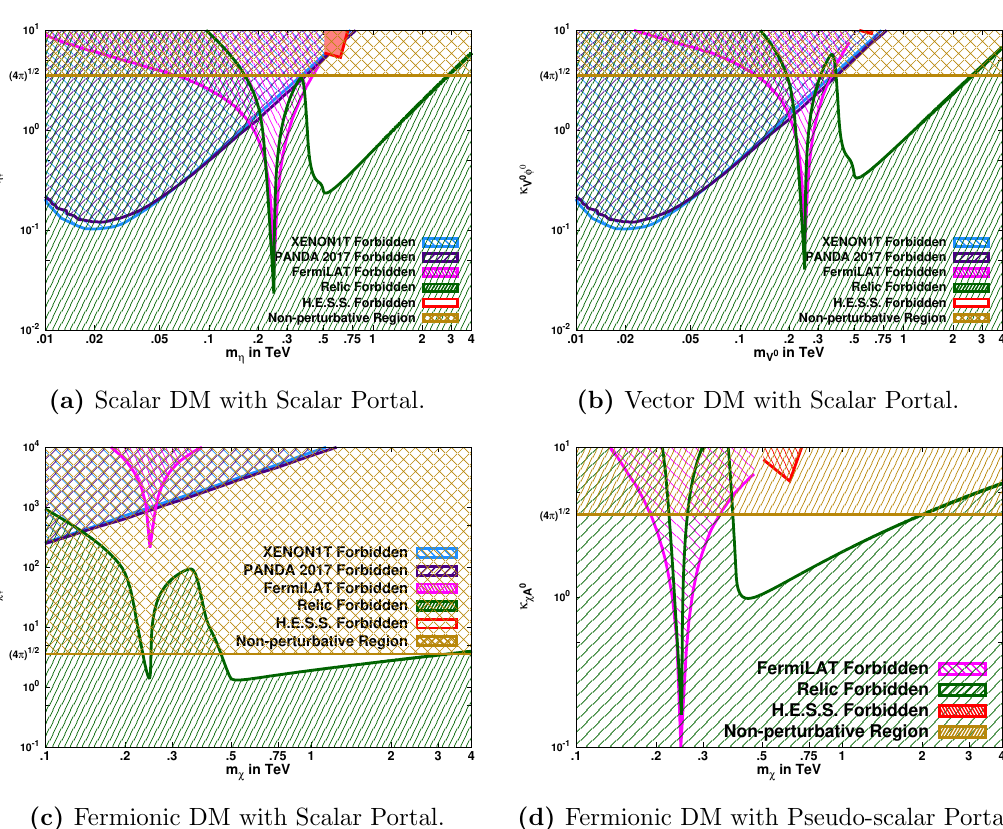
Figure 12. All model constraints are drawn for the portal mass of 500 GeV and VLQ mass 400 GeV. The shaded region correspond to the forbidden regions by relic density [28, 30] (green), XENON1T 2017 [19] (blue), PANDA 2017 [21] (indigo), Fermi-LAT [13] (pink), H.E.S.S. [15] (red) and the perturbativity condition (golden yellow) respectively in the plane de(cid:12)ned by m (cid:17) (cid:0) (cid:20) m (cid:0) (cid:20) , m (cid:31) (cid:0) (cid:20) and m (cid:31) (cid:0) (cid:20) in (cid:12)gures 12a, 12b, 12c, and 12d respectively. Constraints V 0 V 0 (cid:30) 0 (cid:31)(cid:30) 0 (cid:31)A 0 from the direct detection experiments for the pseudo-scalar portal are not shown (see